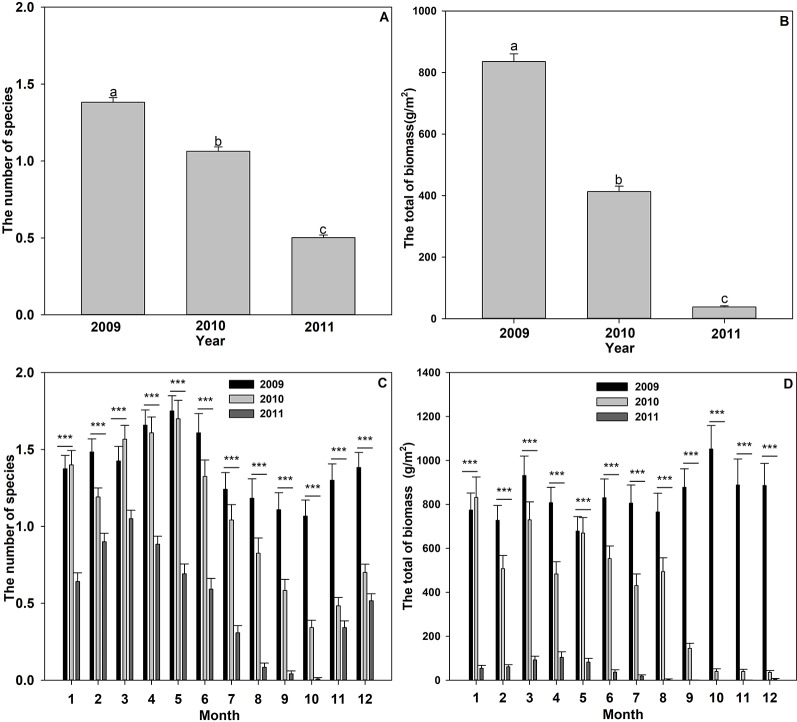
Submerged species number (A, C) and the total biomass (B, D) in different years or different months. Values shown are means ± S.E. Bars with different lowercase letters above are significantly different. Significant differences: ***P < 0.001.